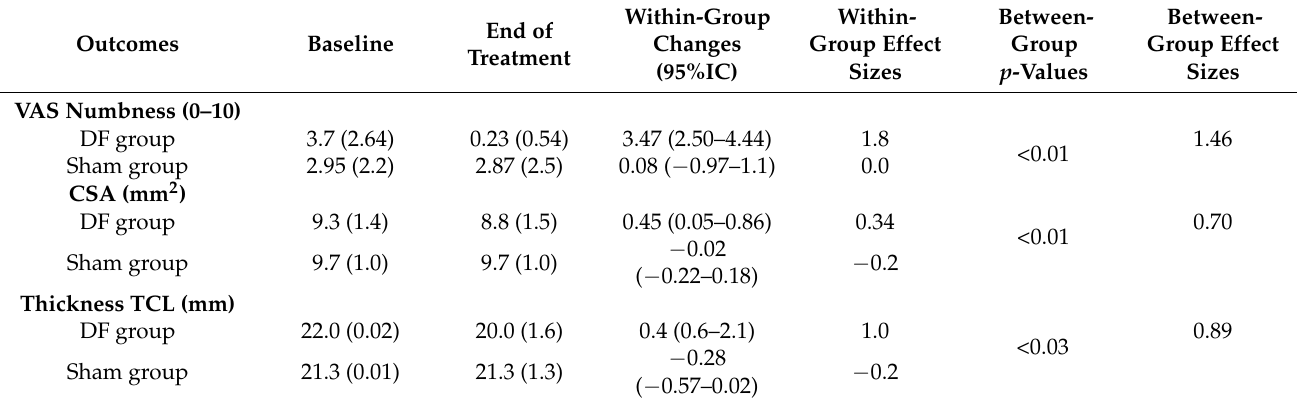
Table 2 provides data between groups and within-group with statistical differences for CSA of the median nerve, thickness in TCL, and numbness intensity. Table 2. Mean values before and after intervention, mean changes and magnitude of numbness, CSA, and thickness of TCL (n = 44 patients, 60